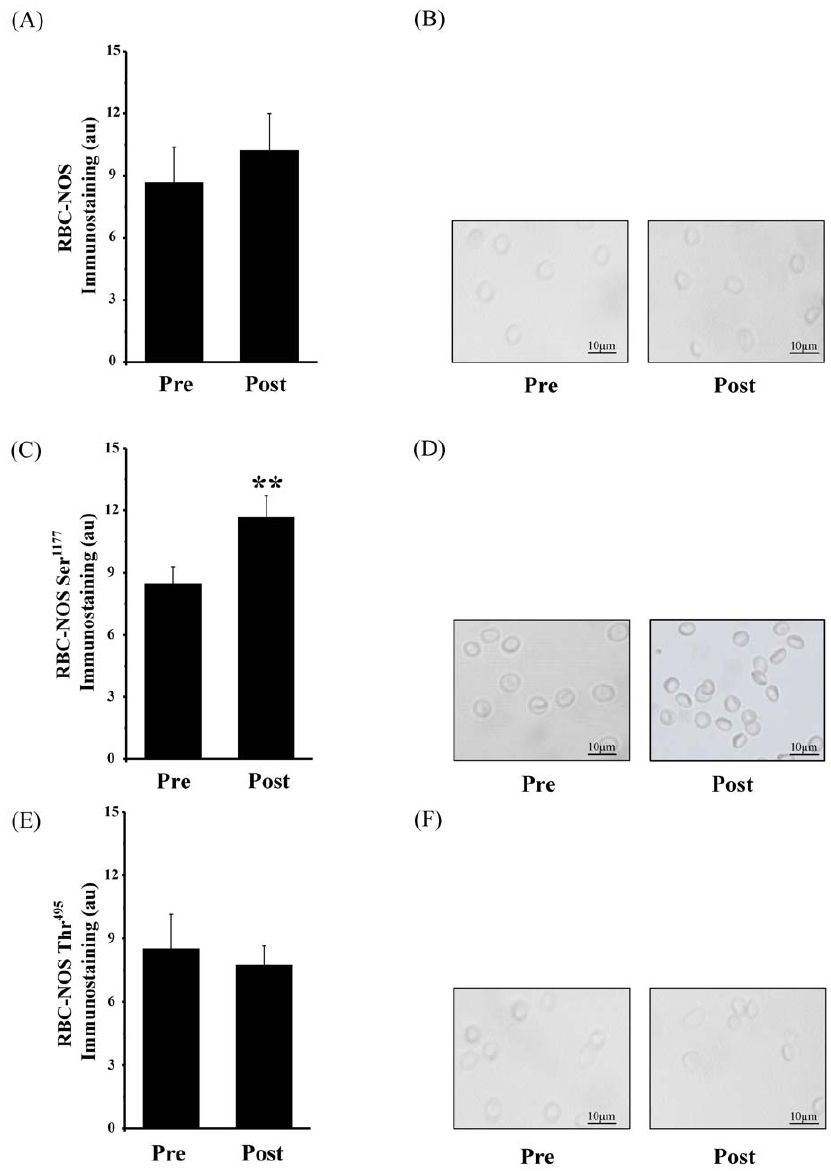
Figure 2. Change in detectable RBC-NOS and RBC-NOS phosphorylation before (Pre) and after (Post) AMRT determined by immunohistochemistry. (A) Bars show statistical analysis of gray values (au) revealing no statistical difference in detectable total RBC-NOS between Pre and Post conditions. (B) shows representative detectable RBC-NOS staining before and after the test, respectively. (C) The data reveal that RBC-NOS phosphorylation at Ser 1177 residue significantly increased from the Pre to Post situation ( P , 0.01). (D) Pictures show representative RBC- NOSSer 1177 staining before and after the test, respectively. (E) The graph shows no statistical difference in gray values (au) between Pre and Post conditions for RBC-NOSThr 495 . (F) Pictures show representative RBC-NOSThr 495 staining before and after the test, respectively. Magnification for all images was 400-fold. Data (A), (C) and (E) are presented as mean 6 S.E.M of n=6.